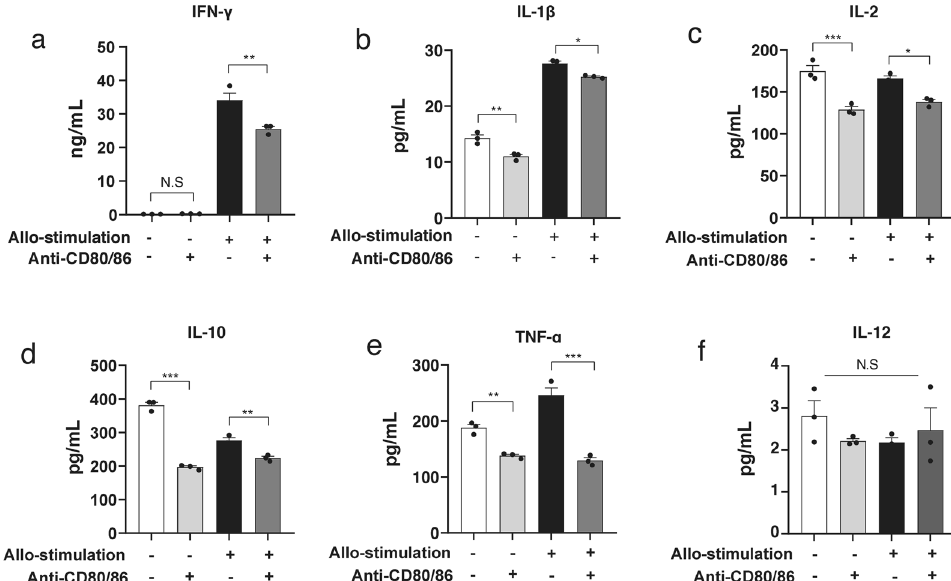
Figure 2. Anti-CD80/86 antibodies reduce pro-inflammatory cytokine production in mixed lymphocyte reaction. ( a ) IFN-γ production reduced by anti-CD80/86 antibodies compared with that without anti-CD80/86 antibodies (n = 3, ** P = 0.005, N.S, P > 0.999, respectively). ( b ) IL-1β production reduced by anti-CD80/86 antibodies compared to that without anti-CD80/86 antibodies (n = 3, ** P = 0.003, * P = 0.021, respectively). ( c ) IL-2 production reduced by anti-CD80/86 antibodies compared to that without anti-CD80/86 antibodies (n = 3, * P = 0.012, *** P < 0.001, respectively). ( d ) IL-10 production reduced by anti-CD80/86 antibodies compared with that without anti-CD80/86 antibodies (n = 3, ** P = 0.004, *** P < 0.001, respectively). ( e ) TNF-α production reduced by anti-CD80/86 antibodies compared with that without anti-CD80/86 antibodies (n = 3, ** P = 0.010, *** P < 0.001, respectively). ( f ) IL-12 production did not change between the groups (n = 3, P =